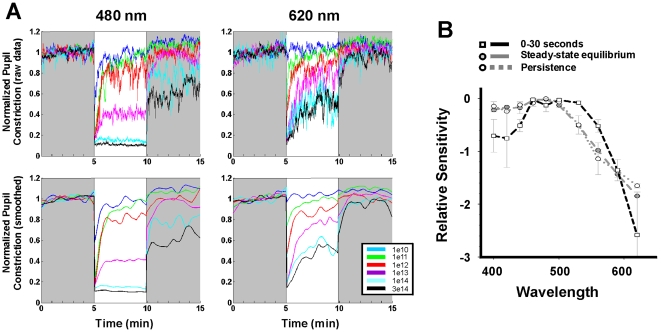
Spectral responses of the pupillary light reflex.(A) Comparison of the PLR to 480 nm and to 620 nm monochromatic long duration (5 min) stimulations at 6 different irradiances in a single subject. The plates above illustrate the raw pupil data and below the smoothed response. Following the initial pupil constriction, the steady state equilibrium and the persistent responses are observable in all but the lowest irradiances and depend on wavelength and light intensity. The amplitude of the steady state equilibrium response is rapidly attained and particularly robust at 480 nm for the highest irradiances used. The persistent responses are also greater at 480 nm compared to 620 nm at equivalent irradiances (see also figure S2). Note that for the higher irradiances (>1e13 photons/cm2/sec) the pupil has not yet returned to the baseline within 5 min after extinction of the stimulus. (B) Action spectrum of the different components of PLR obtained from the intensity dose response curves (as illustrated in A) from 2 subjects. The action spectrum for the first 30 seconds of the PLR (black dashed line) shows broad sensitivity over the blue-green region (460–530 nm). This curve is similar to the spectra obtained between 0–5, 5–10 and 5–30 sec (figure S1) and to data in humans and primates [15], [29]. This profile differs from the action spectrum for the steady state equilibrium and the persistence response functions (respectively the gray dashed and gray dotted lines) that are virtually identical and show maximal sensitivity in the short wavelength region (460–480 nm).